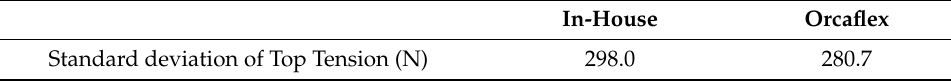
Figure 23. Spectral density of top tension multicomponent line. Table 3. The standard deviation of top tension for the multicomponent case.